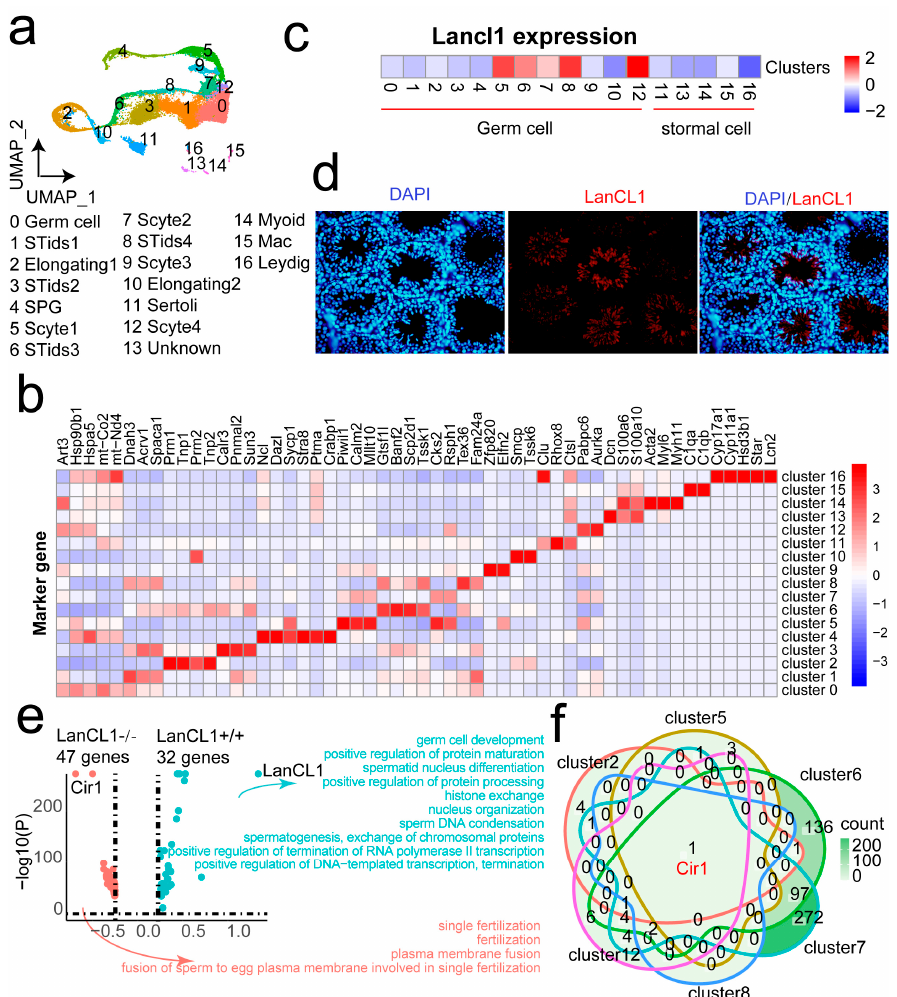
Figure 2. Single ‐ cell RNAseq of the testis identified the high expression of the Cir1 gene in LanCL1 − / − mice. ( a ) UAMP plot of the cell clusters. ( b ) Heatmap of the marker genes in the cell clusters. ( c ) The LanCL1 gene expression in the cell clusters. ( d ) Immunofluorescence of the LanCL1 gene in the testicular tissue. ( e ) The volcano plot of the DEGs in the LanCL1+/+ and LanCL1 − / − mice. ( f ) Venn diagram of up ‐ regulation in the Germ cells of the LanCL1 − / − cell.